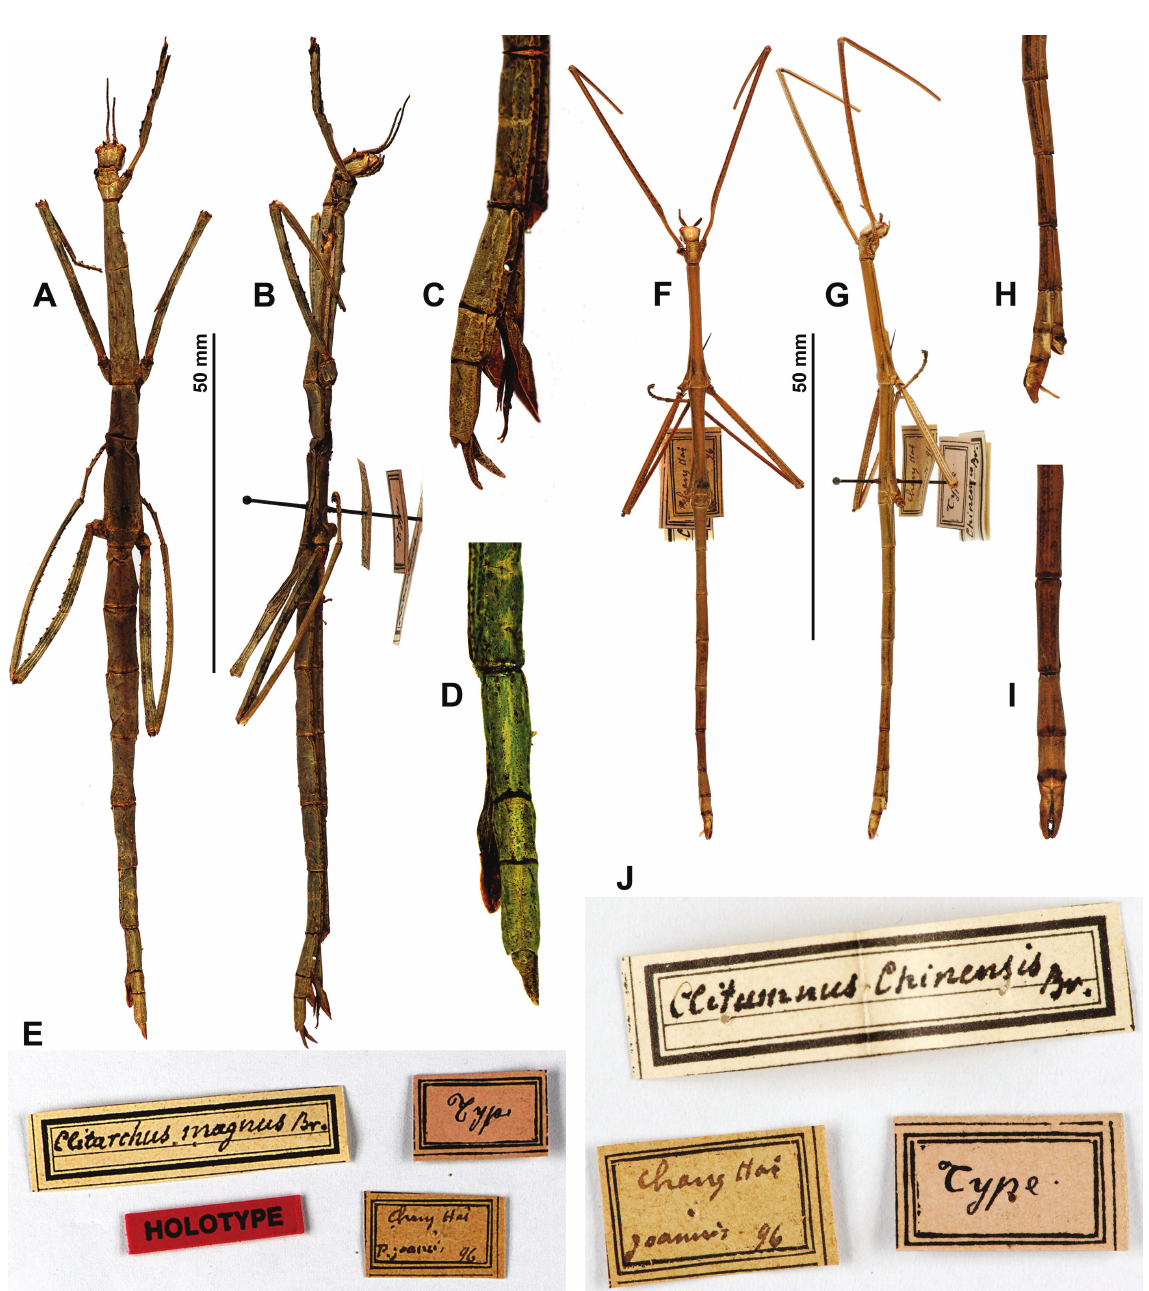
Fig. 2. Baculonistria magna comb. nov. (Brunner von Wattenwyl, 1907). — A–E .Holotype ♀ (MNHN, photographs by Emmanuel Delfosse). A . Habitus, dorsal view. B . Habitus, lateral view. C . Apex of abdomen, lateral view. D . Apex of abdomen, dorsal view. E . Labels. — F–J . ♂ (MNHN, photographs by Emmanuel Delfosse). F . Habitus, dorsal view. G . Habitus, lateral view. H . Apex of abdomen, lateral view. I . Apex of abdomen, dorsal view. J . Labels. C–D, H–I = not to